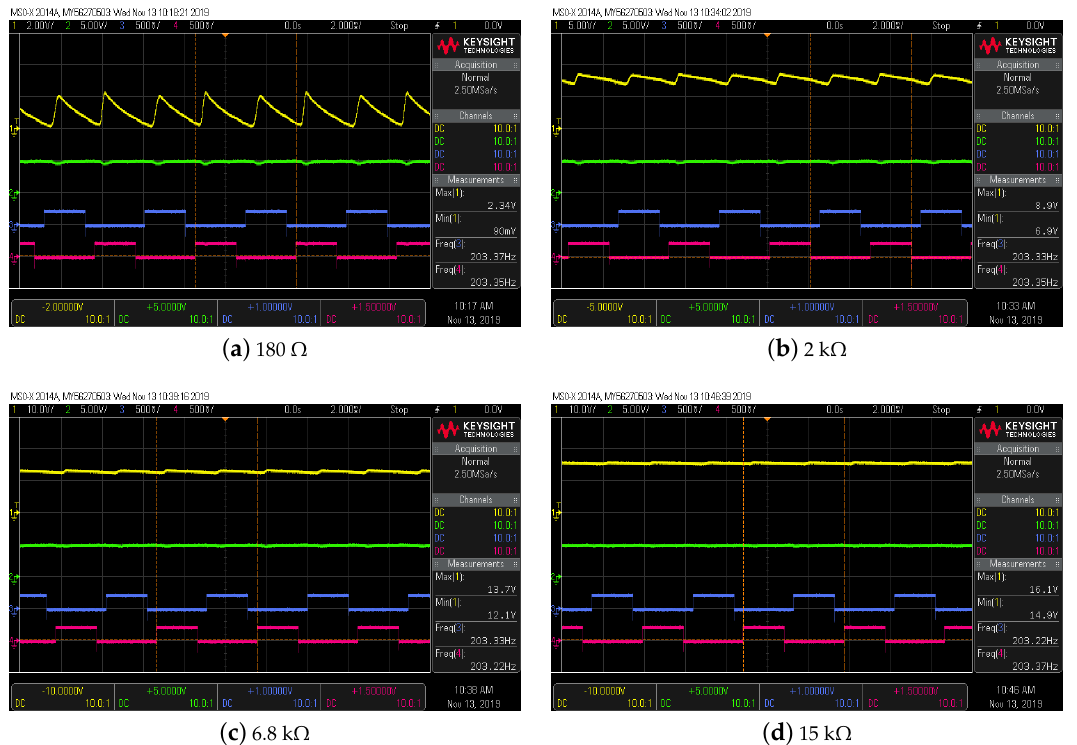
Figure A1. Measured output voltages at different load values from 180 Ω to 15 k Ω